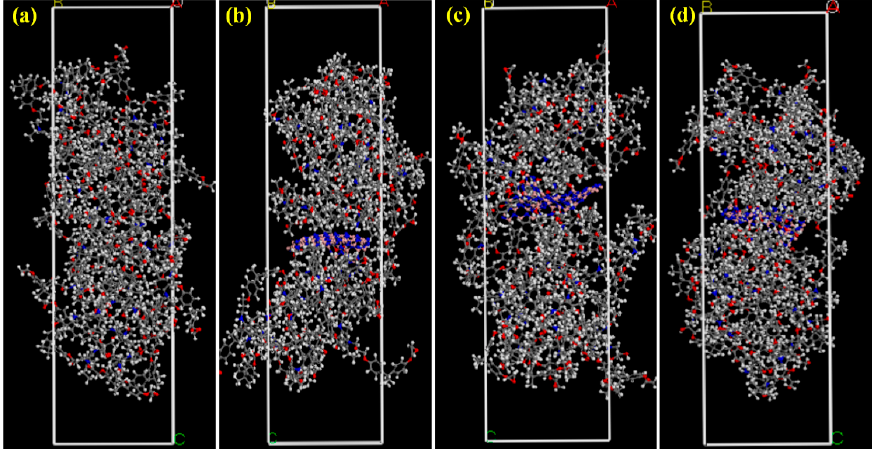
Figure 5. Models for nanocomposites with vacuum layer: ( a ) EP, ( b ) BNNS/EP, ( c ) 4FBNNS/EP, ( d ) 8FBNNS/EP.